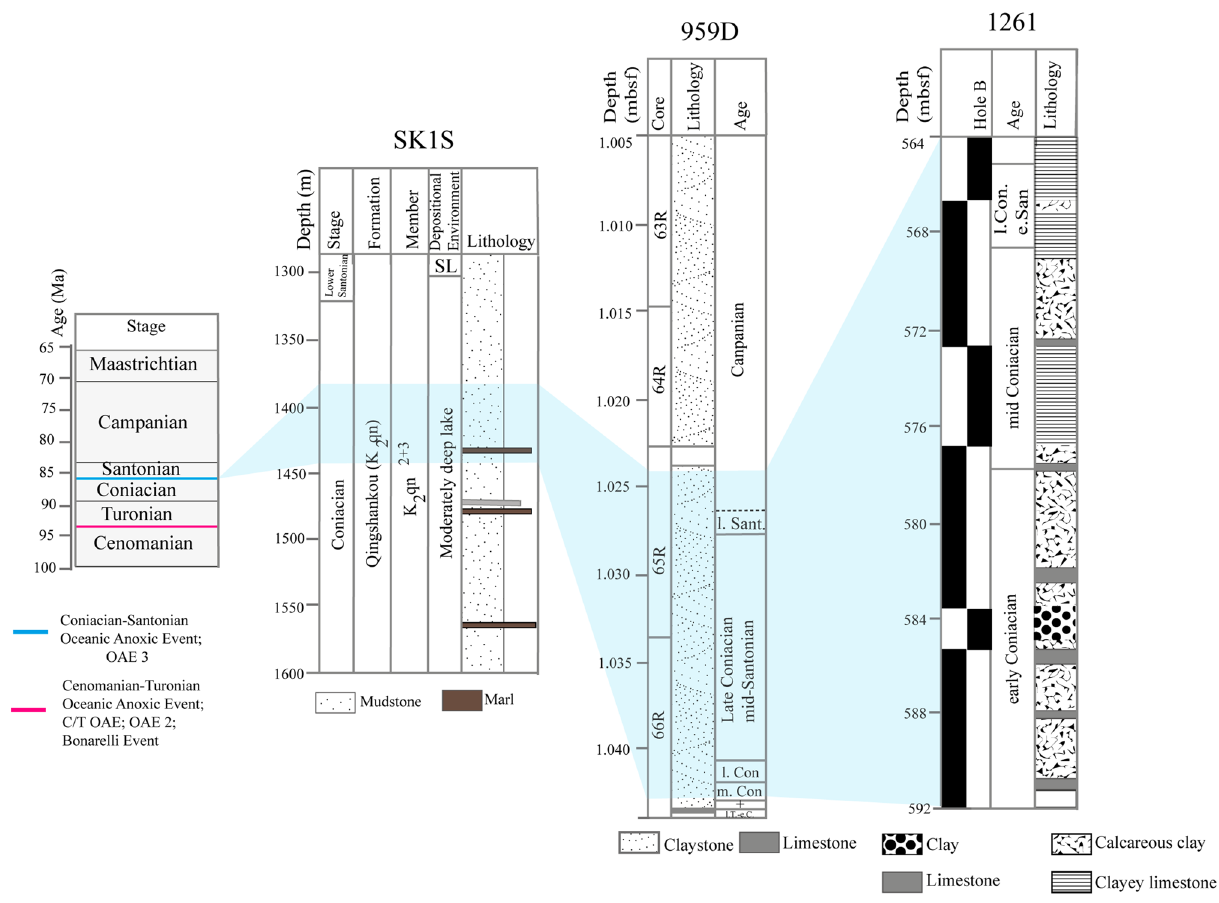
Figure 2. Geology of the studied Coniacian–Santonian OAE interval. The age and the location of the two Late Cretaceous OAEs are from Jenkyns 4 ; the stratigraphy at sites SK1S, 959D and 1261B are modified from Wang et al. 63 , Beckmann et al. 57 and Flögel et al. 89 ,